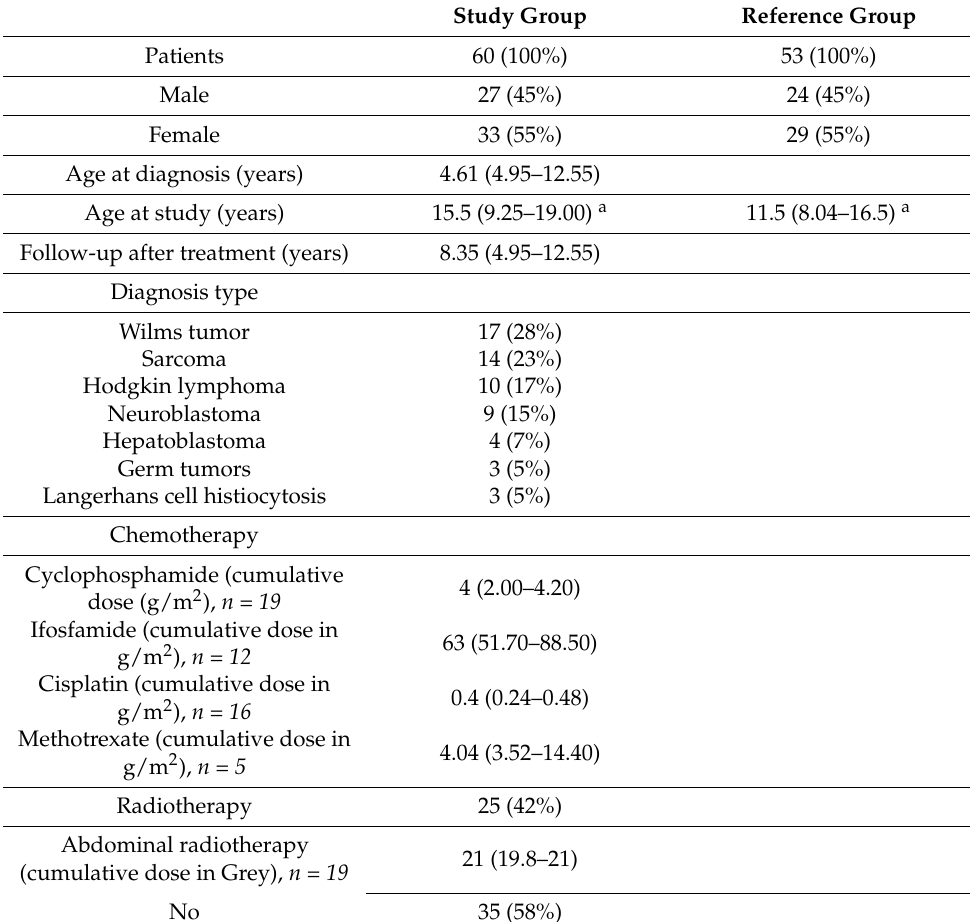
Table 1. Clinical characteristics of the survivors of childhood solid tumors and reference